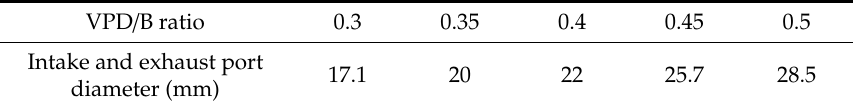
Figure 12. Residual gas fraction versus VPD/B.